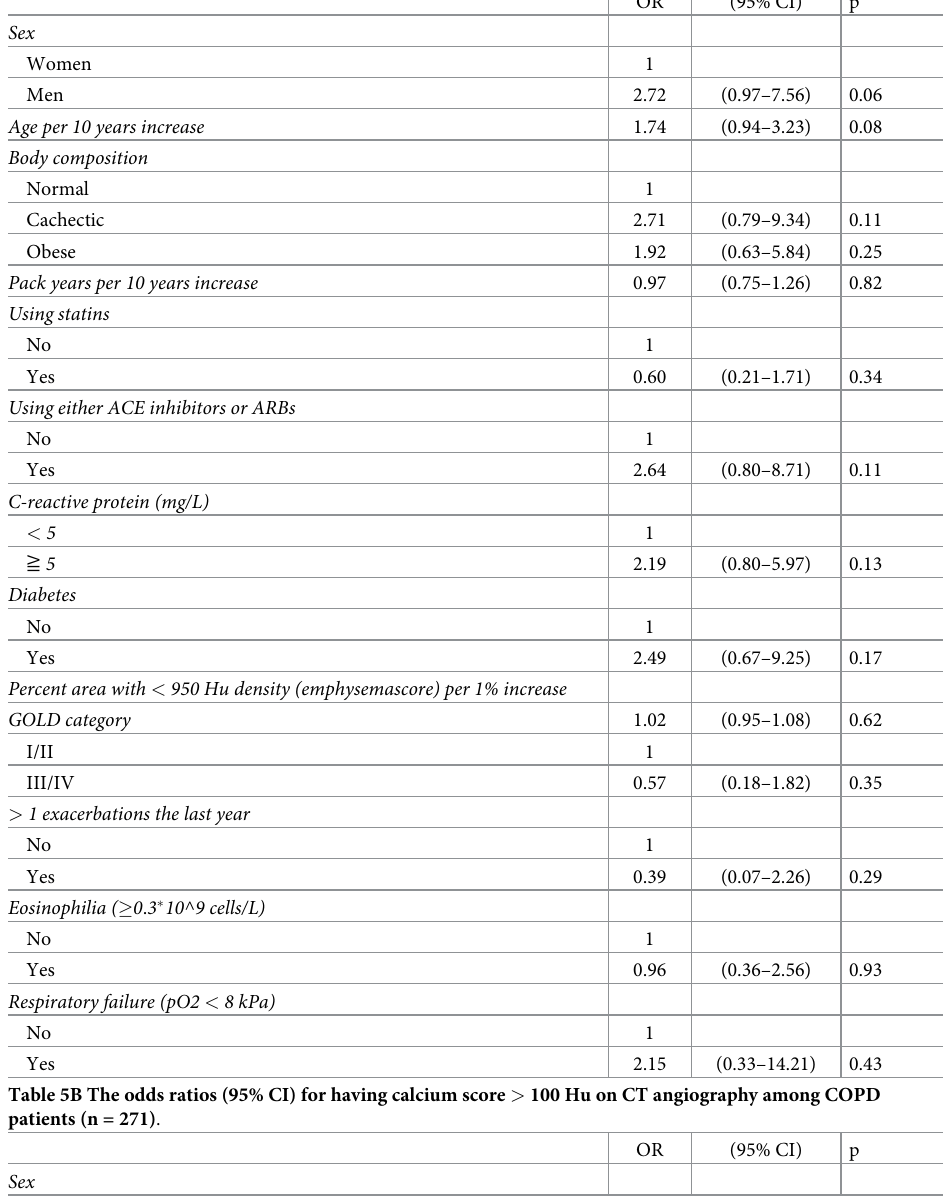
Table 5A. The odds ratios (95% CI) for having significant coronary stenosis on CT angiography among COPD patients (n = 205).